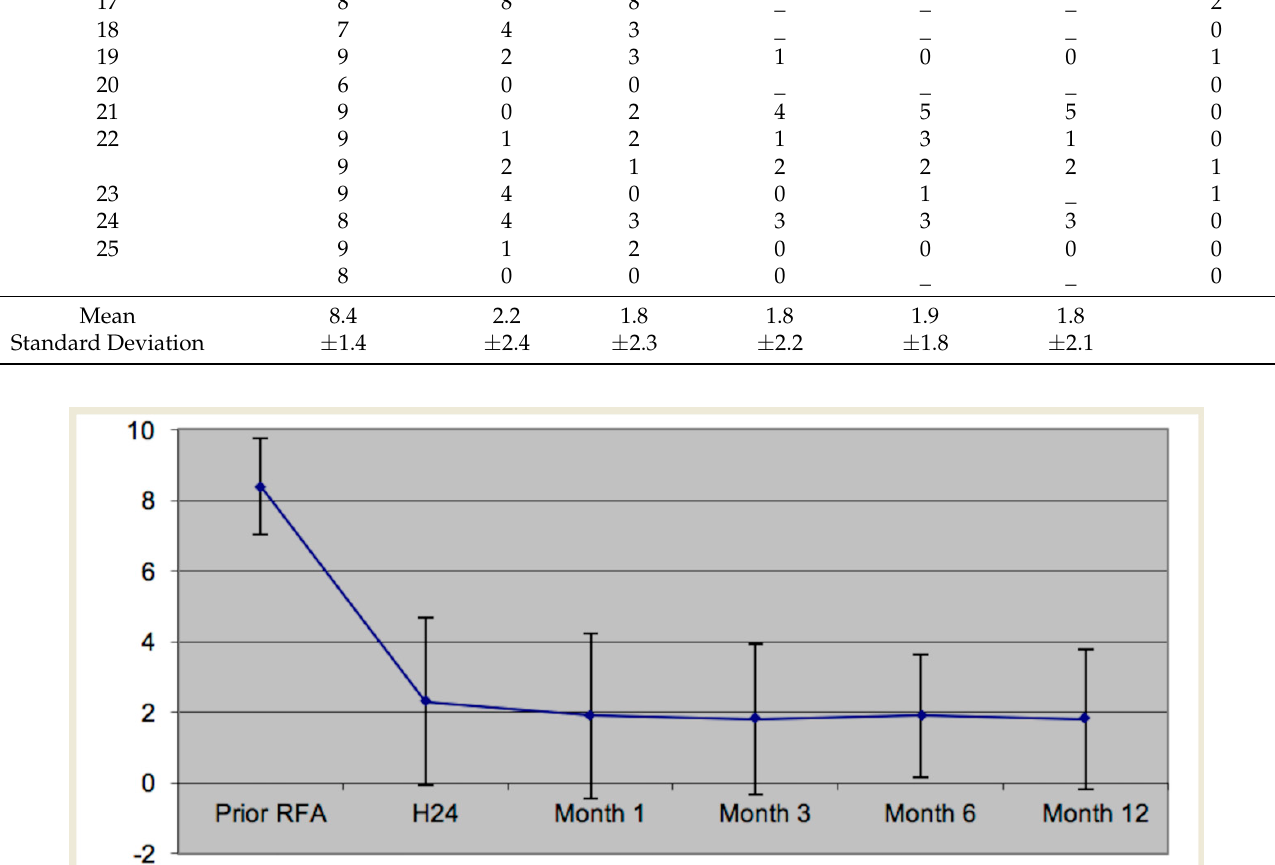
Figure 3. Mean visual analog scale as a function of time.